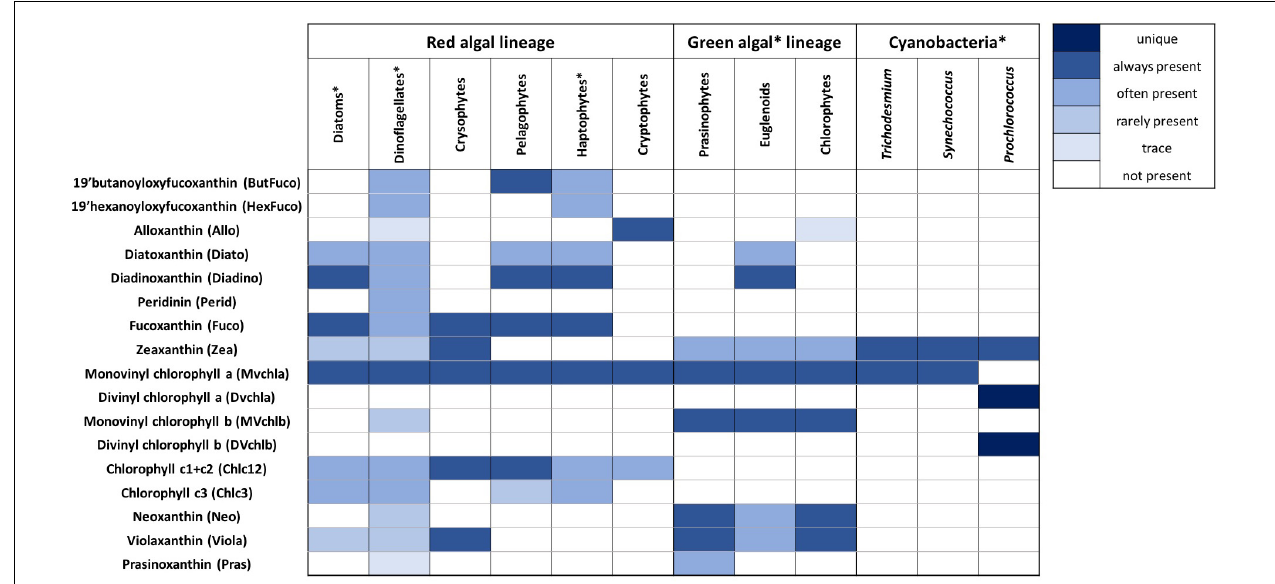
FIGURE 2 | Summary of 17 pigments used in this analysis (16 accessory pigments and monovinyl chlorophyll- a ) and the distribution of these pigments across twelve taxonomic groups, including the five major taxonomic groups identified in this analysis (starred). Known distributions of each pigment in each group (for the species in each group that have been cultured and had HPLC analysis performed) are shown (adapted from Jeffrey et al., 2011 and references therein).